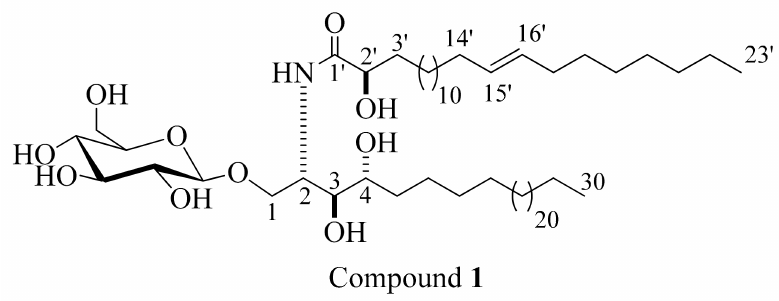
Figure 1. Chemical structure of compound 1 ,